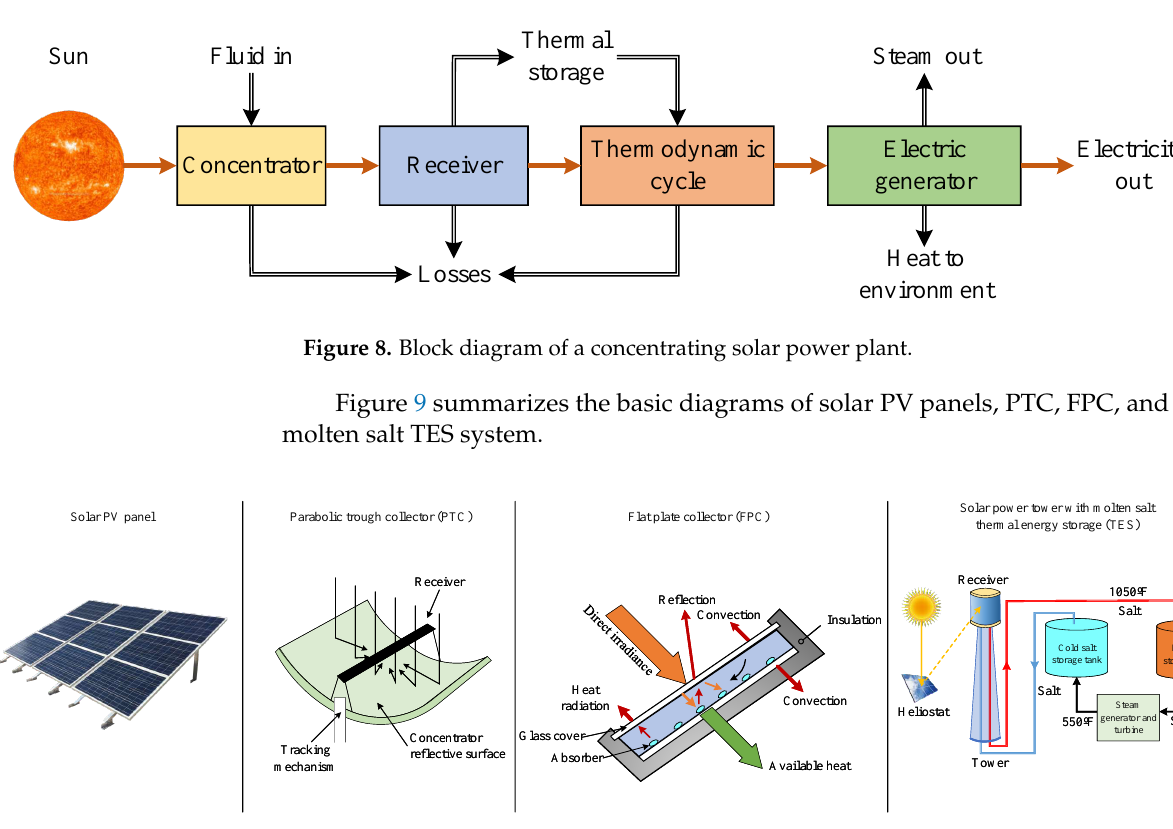
Figure 9. Four prominent solar technologies at a glance—Solar PV, parabolic trough collector (PTC) as an example of the CSP technology, flat plate collector (FPC) as an example of the SHC technology, and solar tower (ST) with thermal energy storage (TES)